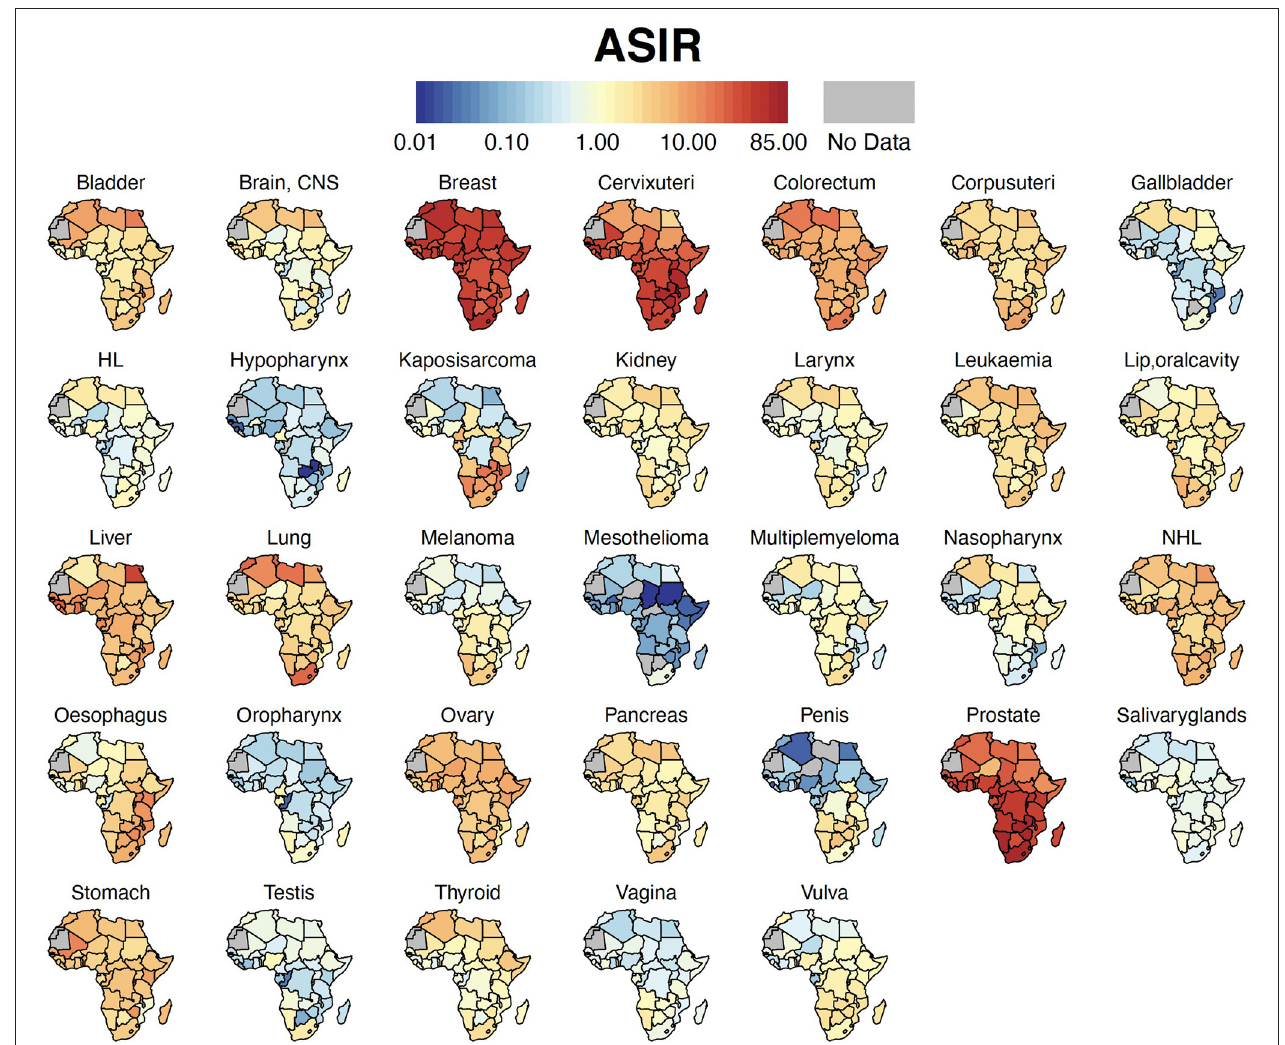
FIGURE 1 | Country-specific ASIR. Cancer ASIR per 100,000 for each country in Africa. ASIR, Age-standardized Incidence Rate; HL, Hodgkin Lymphoma; NHL, Non-Hodgkin Lymphoma; CNS, Central Nervous System.